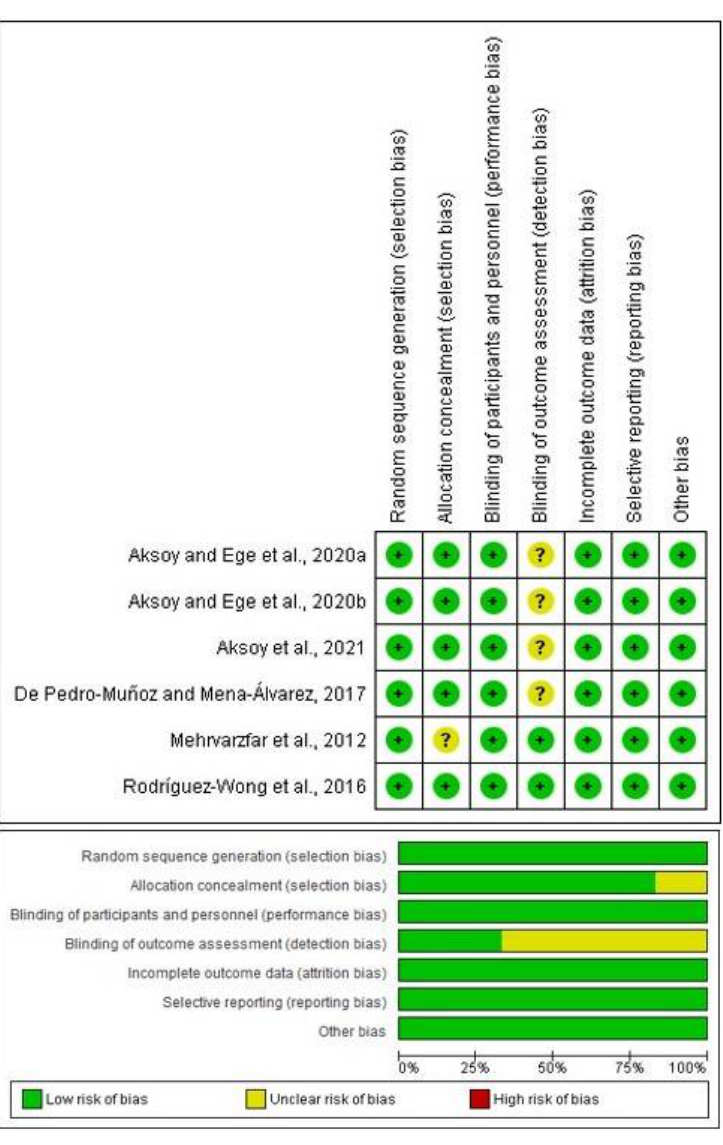
Figure 2. Risk of bias assessment.